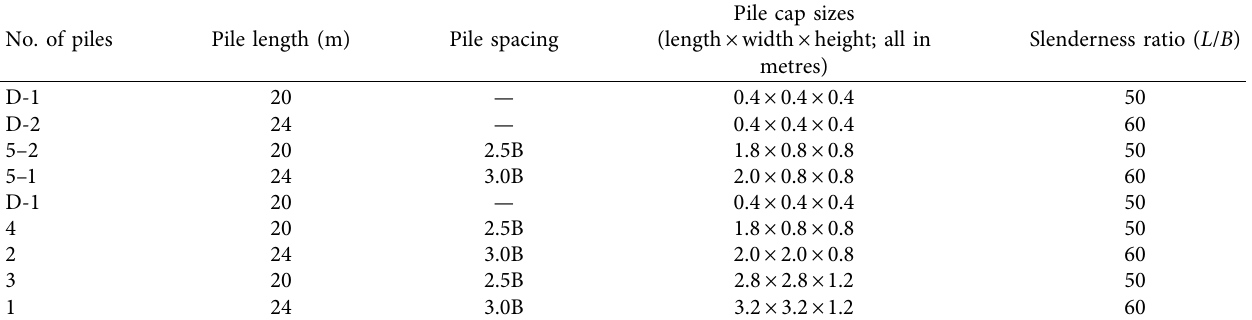
Table 2: Summary of feld